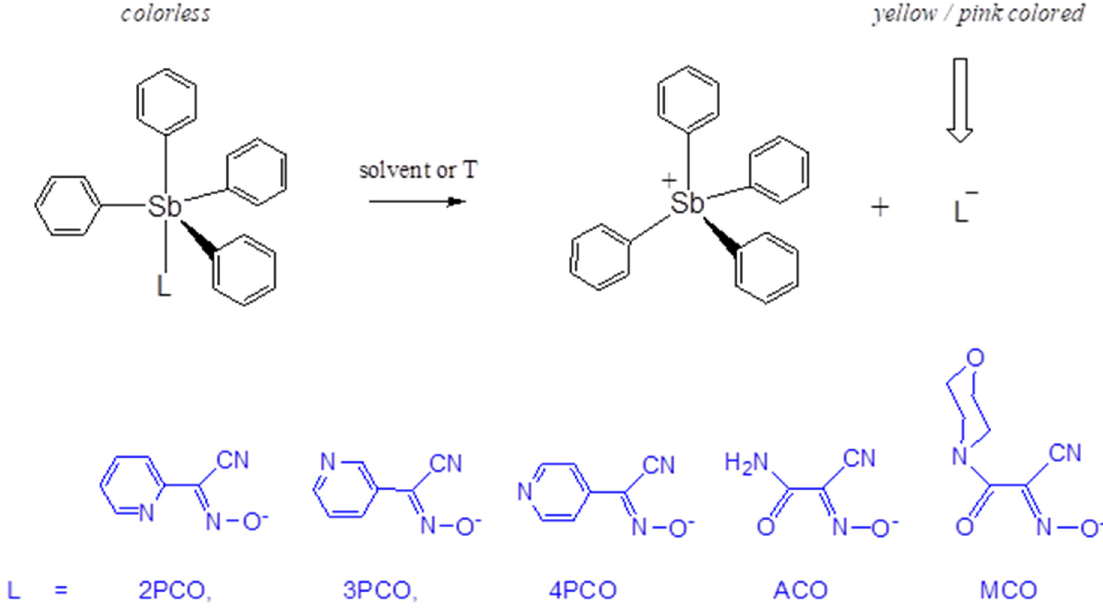
Scheme 1. Representation of the color gain of solutions of organoantimony(V) cyanoximates in the case of the compounds covalent integrity breaking down.